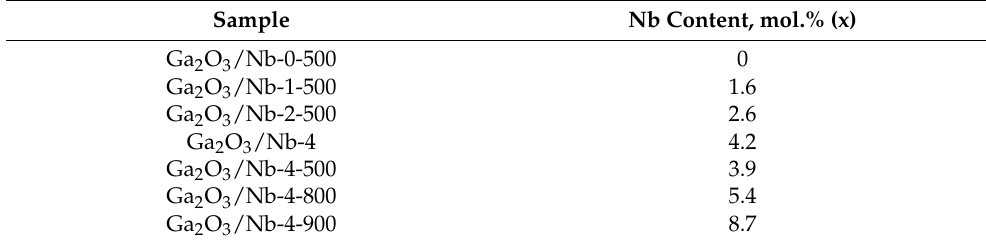
Table 2. Nb content in the synthesized samples according to